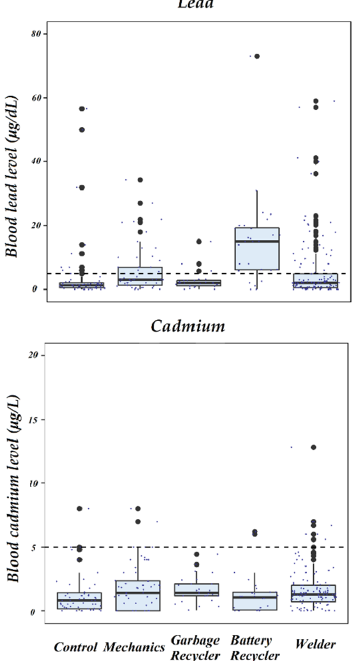
Figure 2. Boxes indicate BLL and BCL by job type, indicating variability outside the upper and lower quartiles. The dotted line refers to the recommended safety limits for Pb and Cd in whole blood [13].